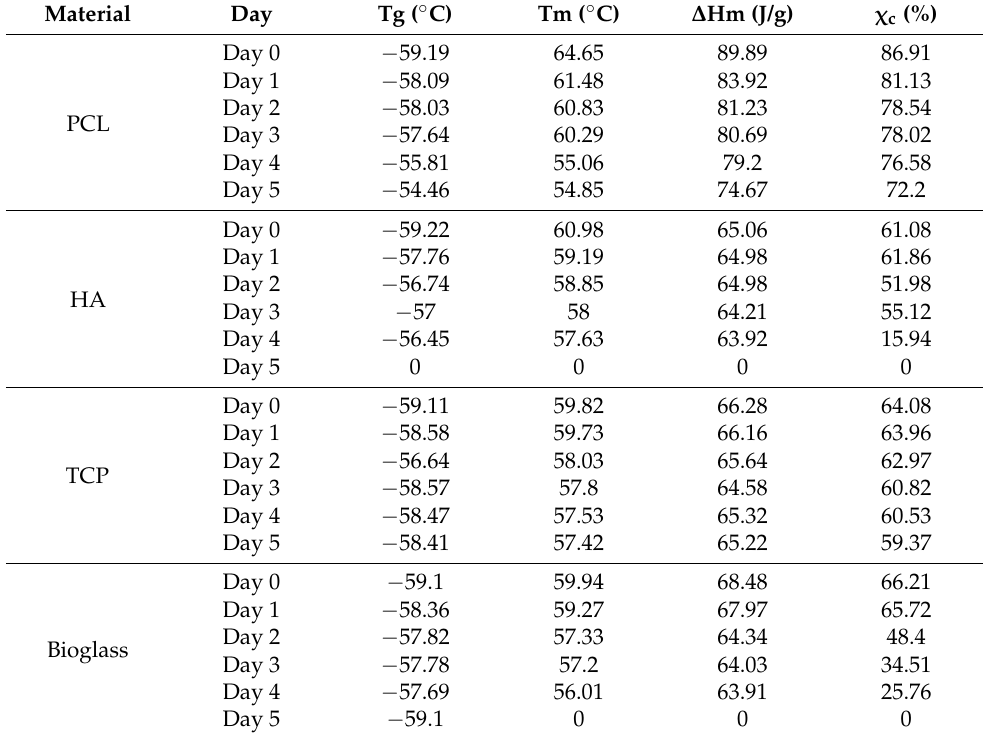
Table 6. Key thermal properties and crystallinity values for all samples at different degradation time points.